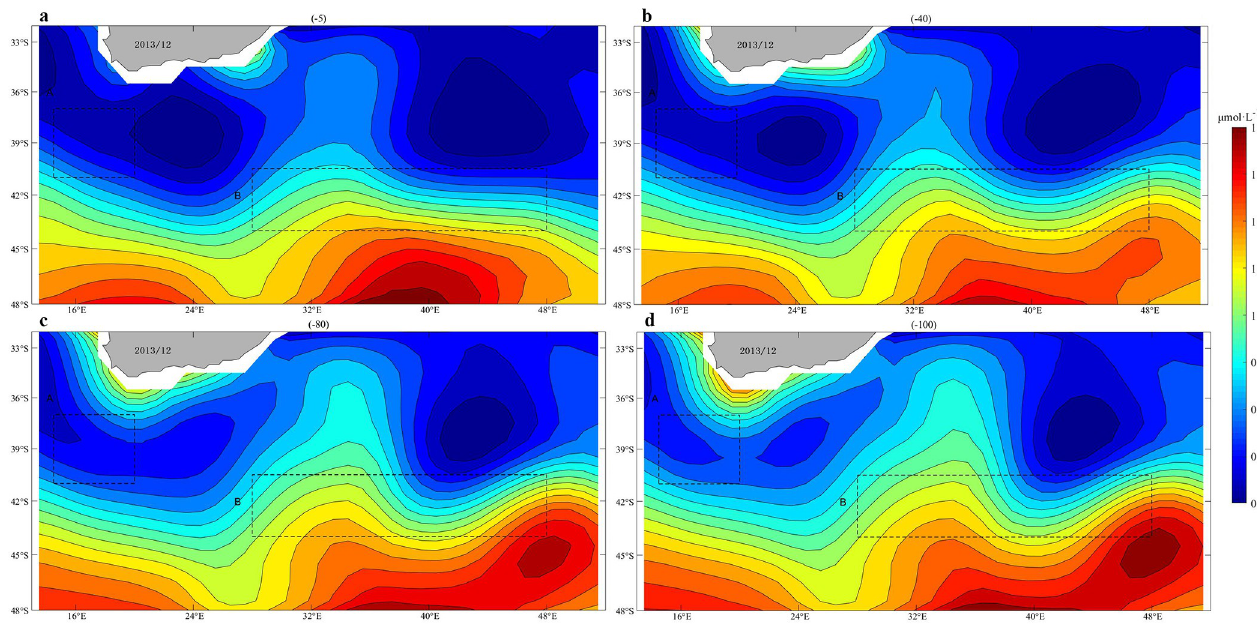
Fig 9. Climatology mean of phosphate concentrations ( μ mol � L-1) in December (the results at depths of -5 m, -40 m, -80 m and -100 m, respectively).